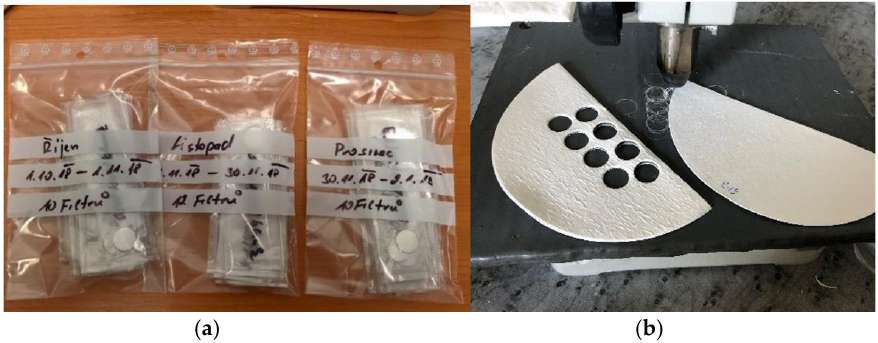
Figure 4. ( a ) A packed set of exposed filter samples, and ( b ) the preparation of samples using the special automatic punching